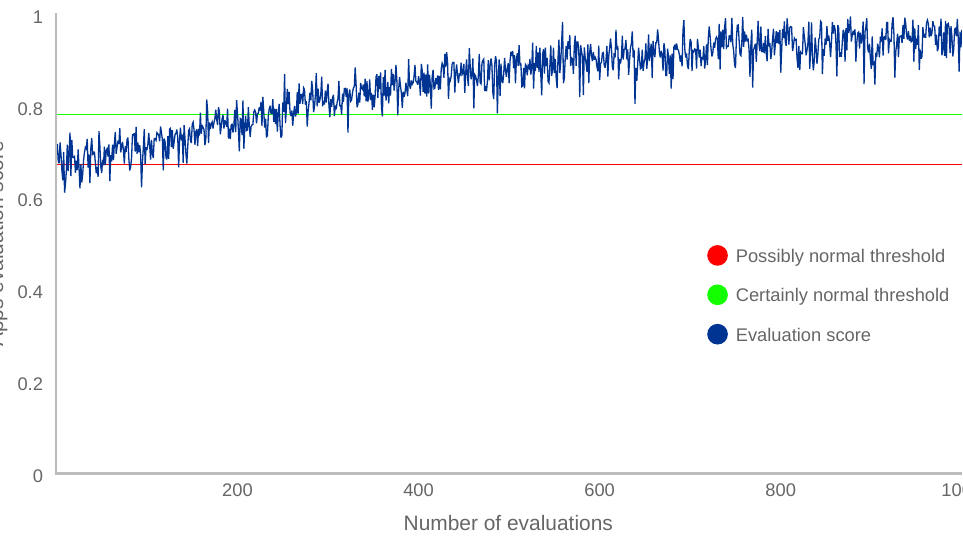
Figure 7. App evaluation scores of the new application vectors as the number of similar new vectors